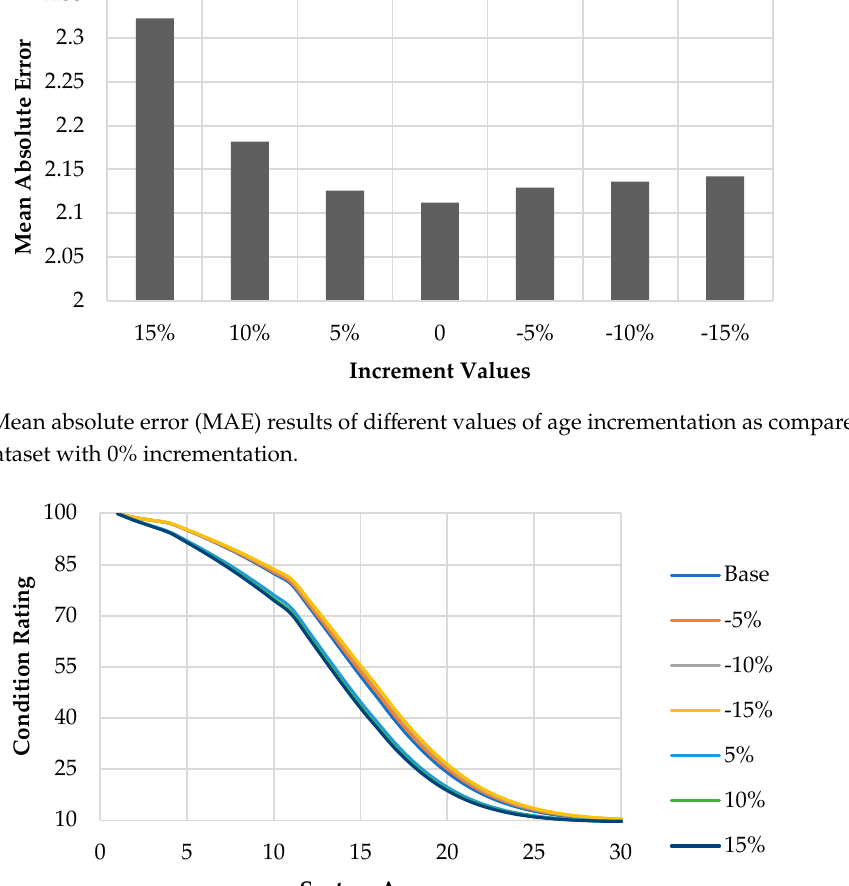
Figure 6. MAE results of different values of condition incrementation as compared to the base dataset with 0% incrementation. Figure 6 shows that the minimal MAE is obtained by the base initial hypothesis for the condition membership functions, while the highest MAE is associated with the positive 15% incrementation of the condition membership functions, which proves that the initial assumption is a better candidate for representing the datasets acquired from actual hospital building assets. However, the effect on the overall life expectancy of the oxygen gas systems obtained from the base assumption and the corresponding incrementations of +5, +10, +15% and − 5, − 10, − 15% does not exceed the value of 0.07692 representing a change of less than 10% in the output resulting from the fuzzy-based analysis